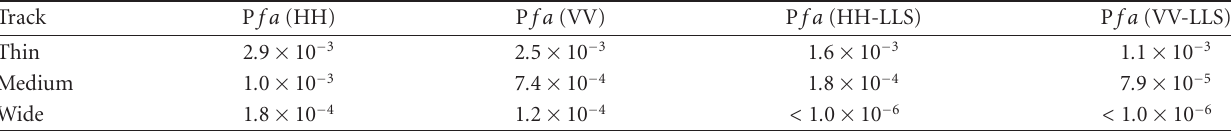
Table 3: Probability of false alarm for a probability of detection of 1 in 10 for the di ff erent track changes, polarisation channels, and detection